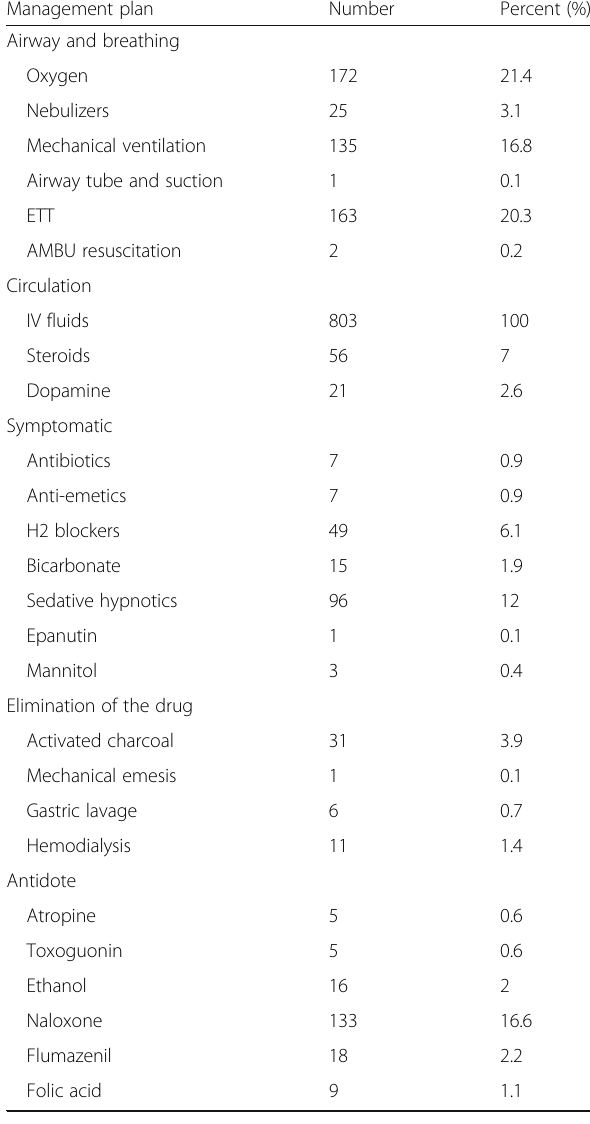
Table 7 The treatment of addictive drug-induced acute toxicity of patients under the